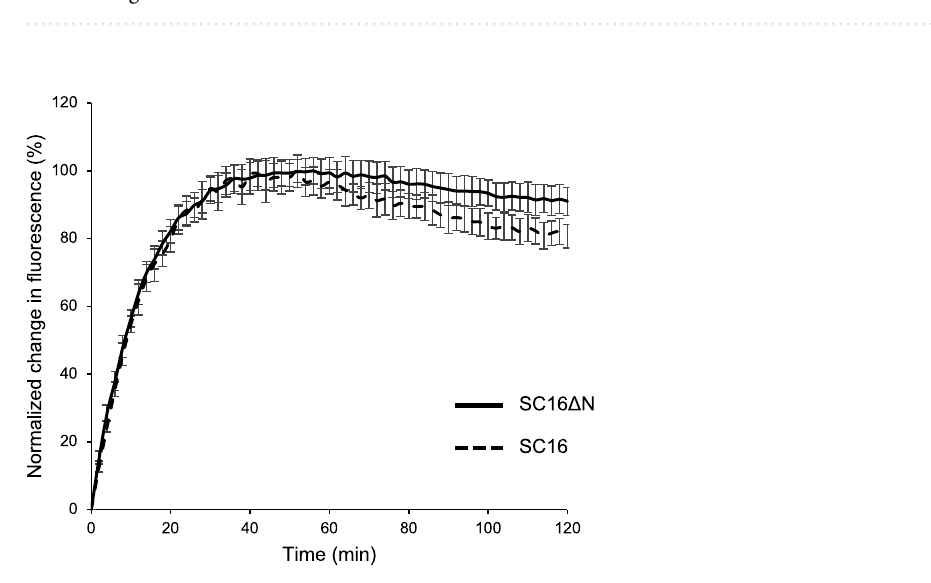
Figure 2. T1, T2, and NOE relaxation measurements identify the N- and C-termini and L 2 of SC16 as dynamic. T 1 , T 2 , and NOE measurements were collected for 15 N 13 C-labelled SC16 and are plotted on a per-residue basis. Residues that have elevated T 2 and decreased NOE values relative to the rest of the molecule are indicated with blue shading.